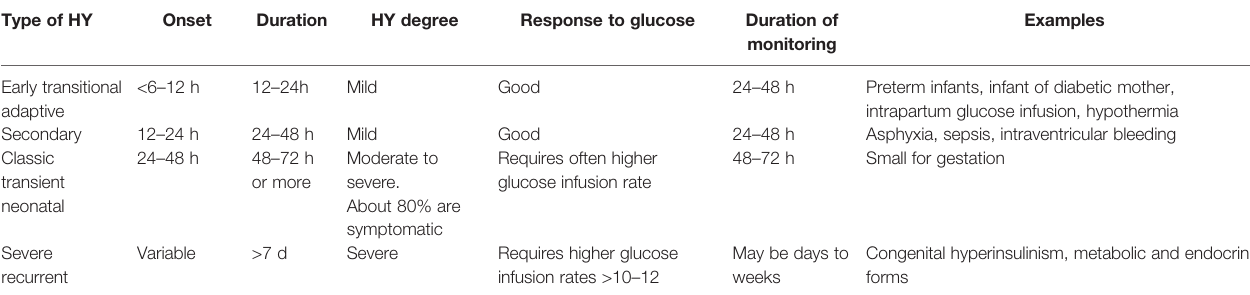
TABLE 3 | Glucose monitoring for neonates at risk for